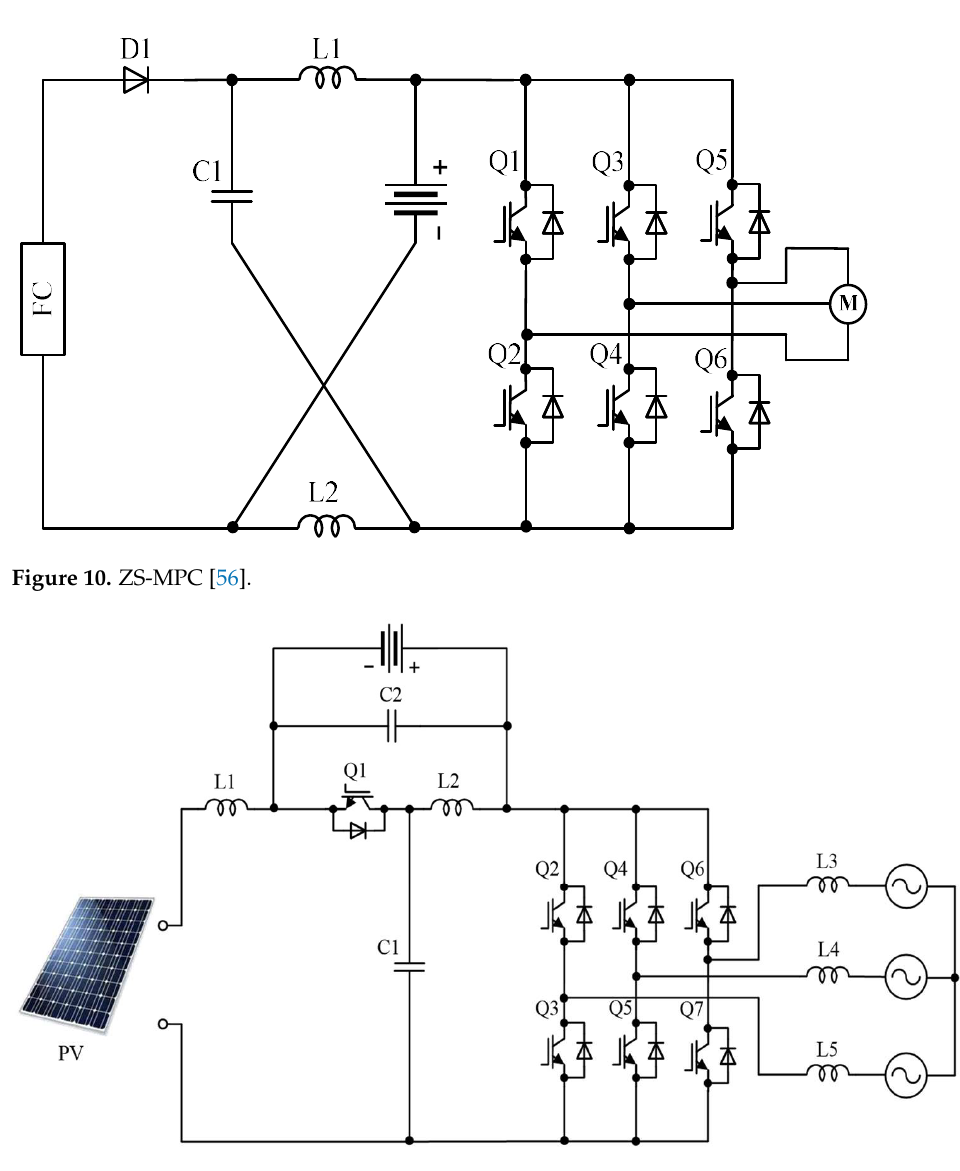
Figure 11. qZS-MPC with Battery Storage Paralleling an Upper Capacitor [57].